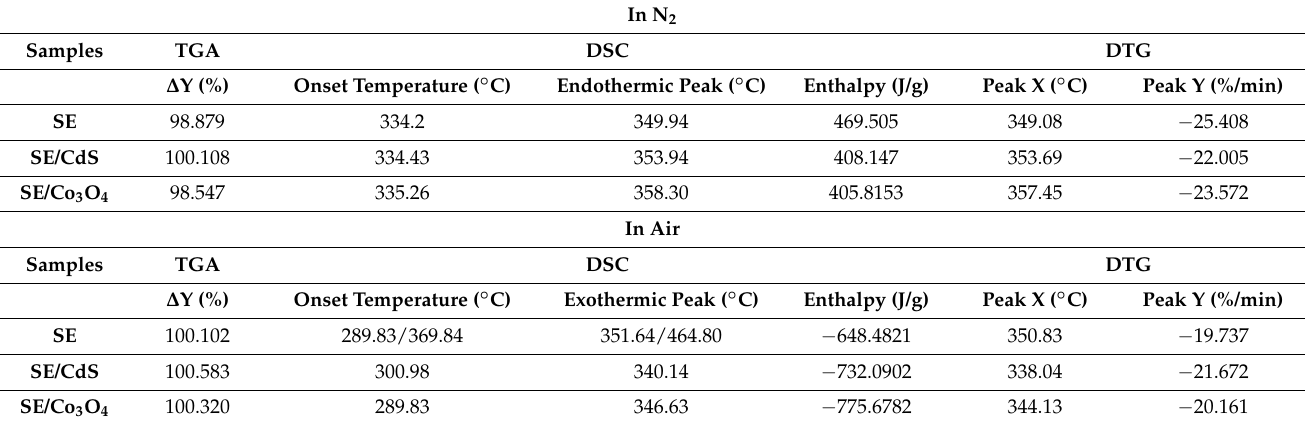
Table 7. TGA–DSC–DTG results of synthetic ester oil and nanofluids in air and N 2 . In N